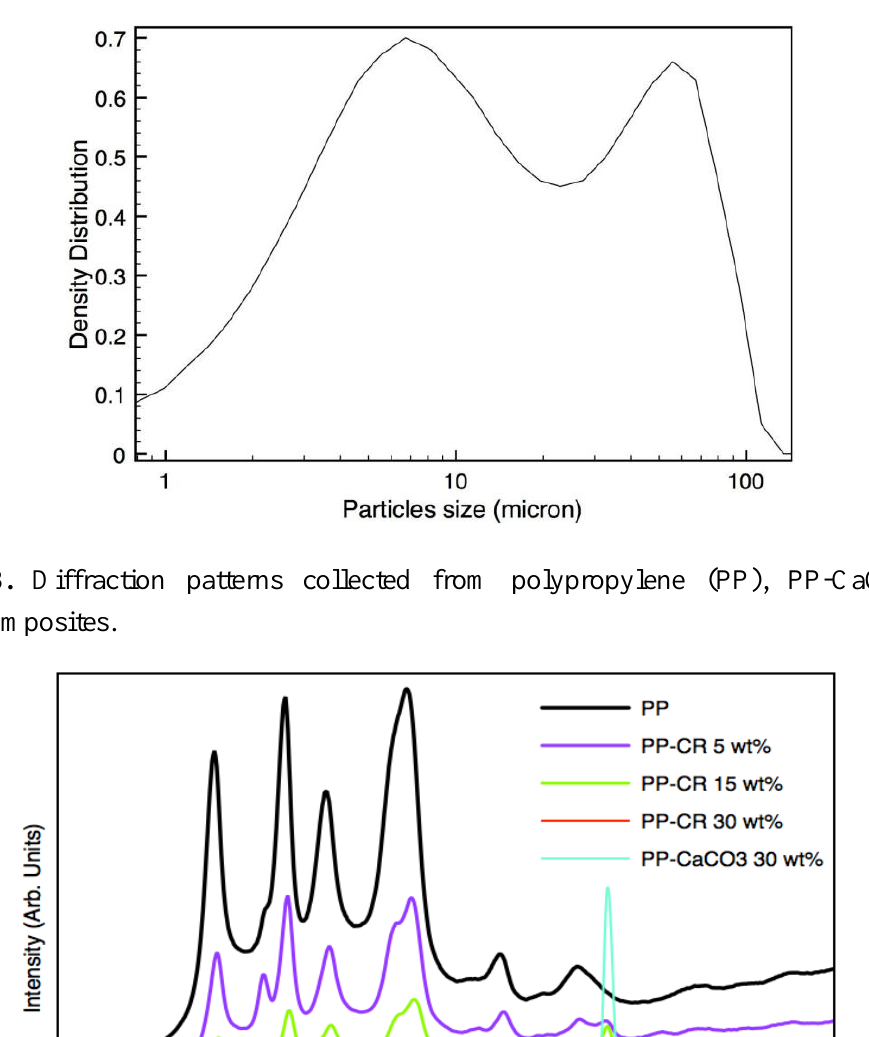
Figure 2. Particle size distribution for rice husk silica based (CR) sample determined by laser diffraction.